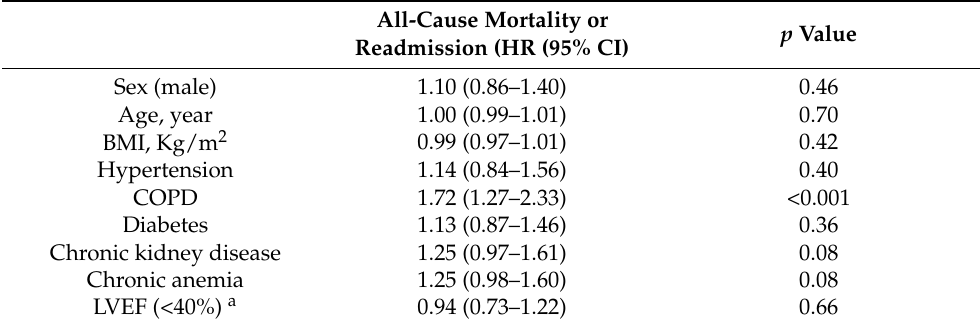
Table 2. Unadjusted analysis of association with 90 day all-cause mortality and readmission.